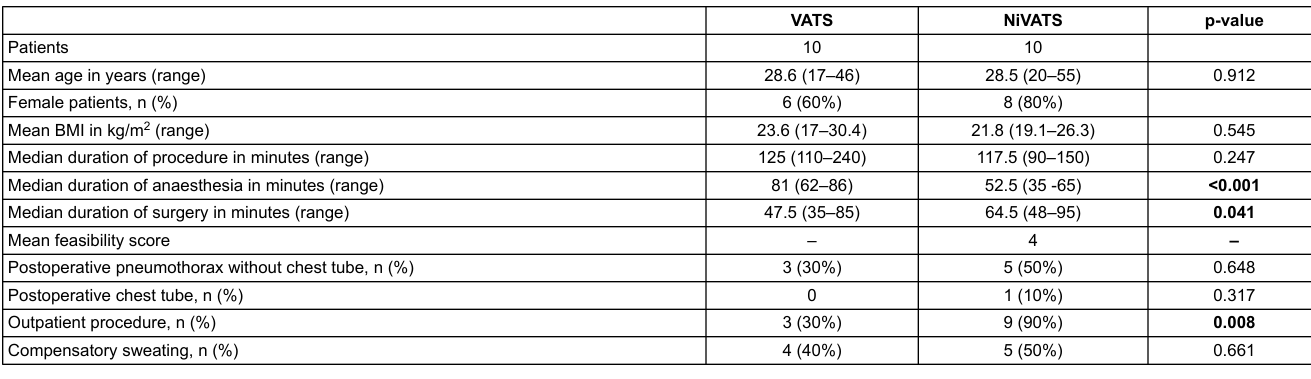
Table 3: Characteristics of all